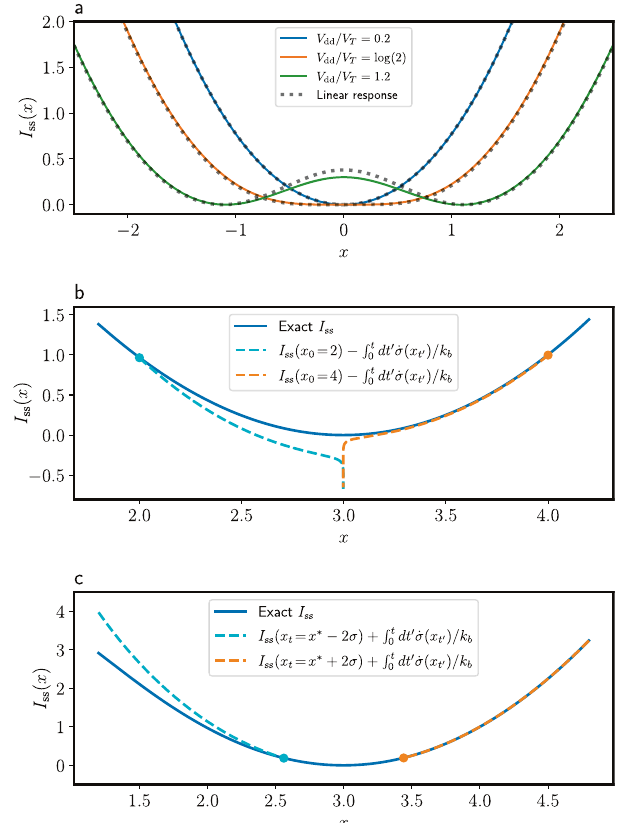
Fig. 2 | Rate function of the CMOS memory. a Rate function I ss ( x ) for different valuesof thepowering voltage V dd .We alsocompare I ss ( x )withthe linearresponse approximation obtained from Eq. (23) for V dd =1.2. b Illustration of the bound to I ( x t ) in Eq. (18) for two different deterministic trajectories starting at x 0 =2 and x 0 =4 ( V dd =3). c Bound to I ss ( x 0 ) for a fi xed x t according to Eq. (18), for x t = x * ±2 δ ffiffiffiffiffiffiffi p ( δ =1 = 2 Ω , Ω =10, and V dd =3).